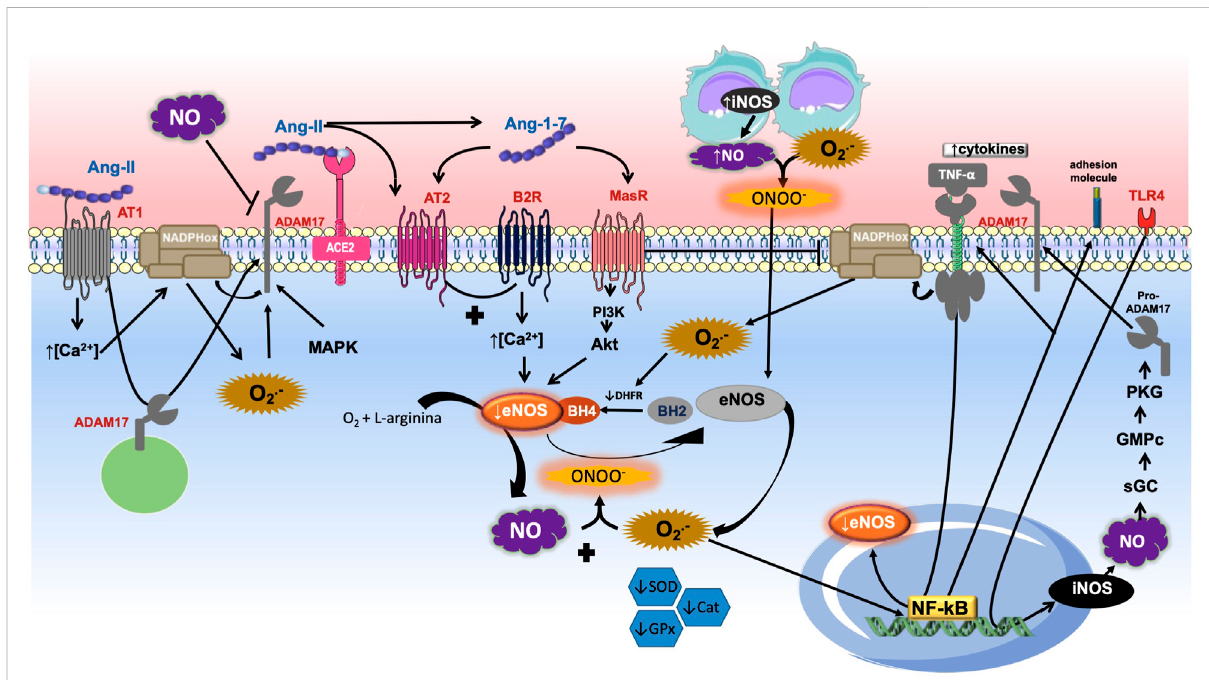
FIGURE 2 Role of ADAM17-mediated shedding and nitric oxide (NO). The Angiotensin-II (Ang-II) binding into Ang-II type 1 receptor (AT 1 R) induces the calciumconcentrationincrease,whichpromotesnicotinamideadenine dinucleotide phosphate oxidase(NADPH oxidase)stimulationandincreases the production of superoxide anion (O 2 - ), which interacts with NO to produce peroxynitrite. Reactive species oxidize BH4 to BH2 causing eNOS uncoupling. The binding of Ang-II into its receptor causes desintegrin and metalloprotease 17 (ADAM17) moving to the membrane and its activation directly. ADAM17 also can be activated by reactive oxygen species (ROS) and MAP kinase family (MAPK). Once the ADAM17 is in the cell surface it induces shedding of diverse membrane-anchored proteins such as the angiotensin converting enzyme type 2 (ACE2), inhibiting the conversion of Ang-II into Ang-(1 – 7). The heptapeptide binds into Mas receptor (MasR) which induces PI3K/AKT pathway stimulation and NO formation through endothelial nitric oxide synthase (eNOS). Similarly, Ang-(1 – 7) is able to promote Ang-II type 2 (AT2R) receptor activation, which stimulates the bradykinin (BK)-NO cascade by bradykinin type 2 receptor (B2R). The increase of inducible NOS (iNOS) promotes NO production, which in the presence of high concentrations of O 2 - induces peroxynitrite (ONOO − ) formation, further contributing to the uncoupling of eNOS. In addition, decreased levels of the endogenous antioxidants superoxide dismutase (SOD), glutathione peroxidase (GPx), and catalase (Cat) were observed. The pro-in fl ammatory binding of tumor necrosis factor α (TNF- α ) into its receptor stimulates NADPH oxidase and ROS formation. O 2 - induces nuclear factor Kappa-B (NF- κ B) promotion and decreasing eNOS, activation of adhesion molecules and enhance of TNF- α pathway. This fi gurealsoshowsthattheactivationoftoll-likereceptor4(TLR4)stimulatesthetranscriptionofiNOSandconsequentactivationofguanylatecyclase (sGC), cyclic guanosine monophosphate (cGMP), protein kinase G (PKG) pathway. It promotes the maturation and translocation of ADAM17 to cell surface, with consequent shedding of TNF- α receptor and decreasing of in fl ammation